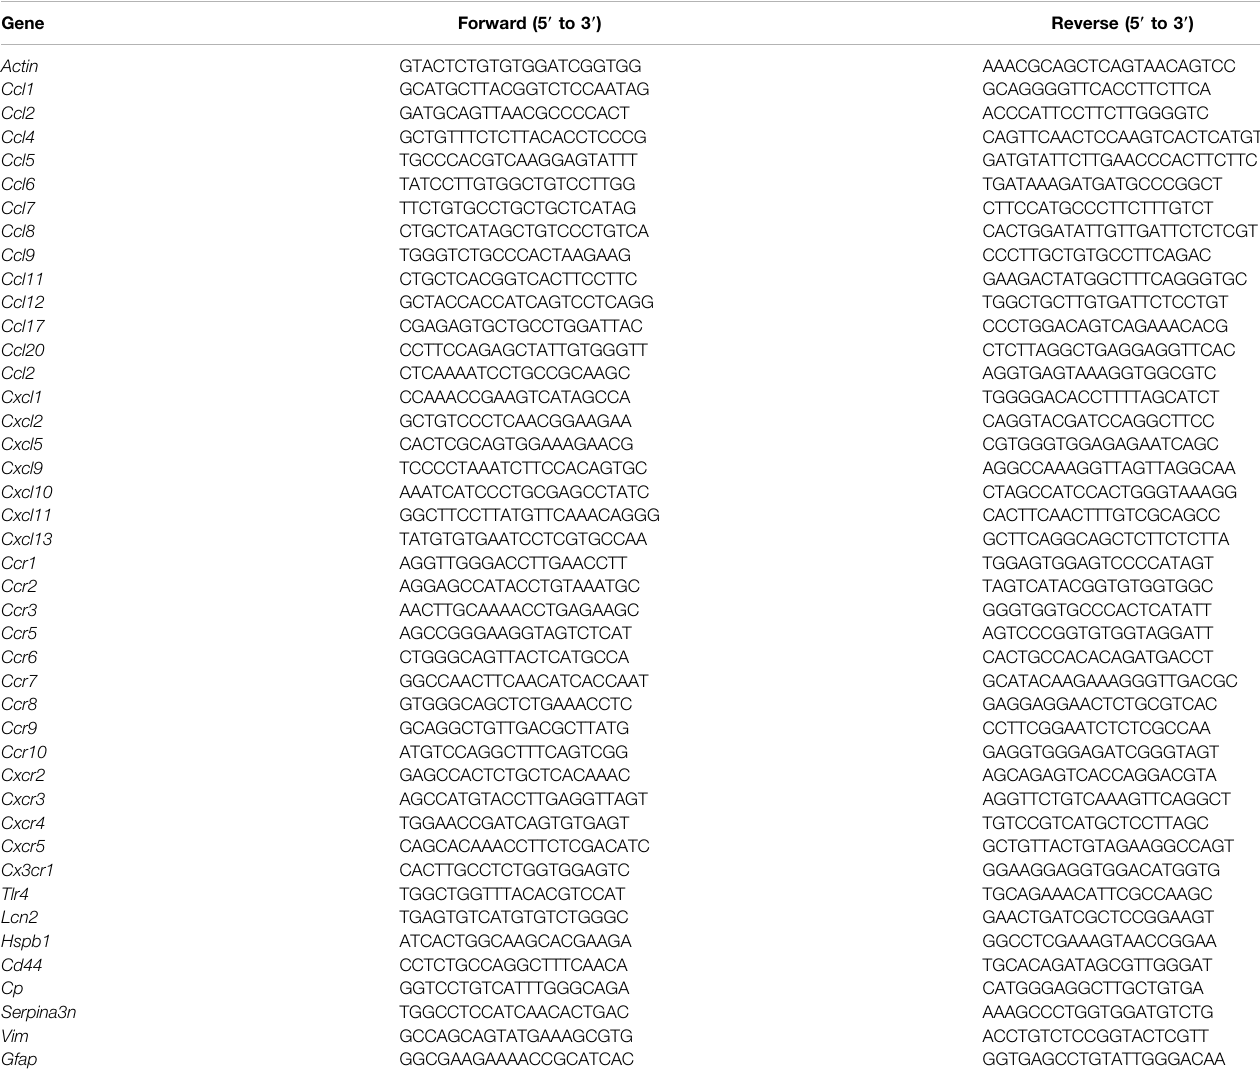
TABLE 1 | Oligo nucleotide sequences of the primers used for